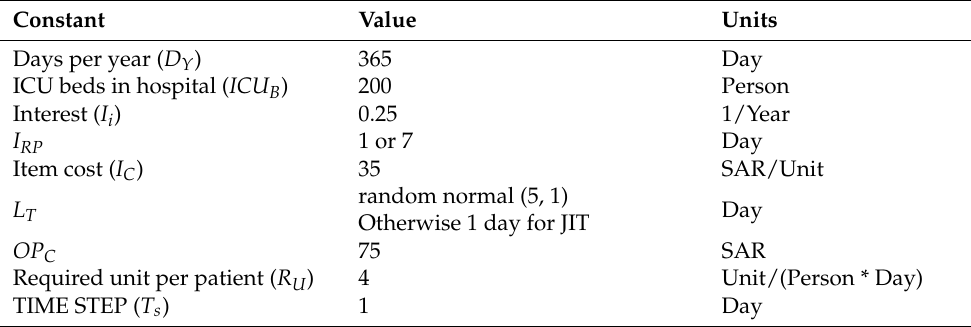
Table 2. Constants used in the inventory